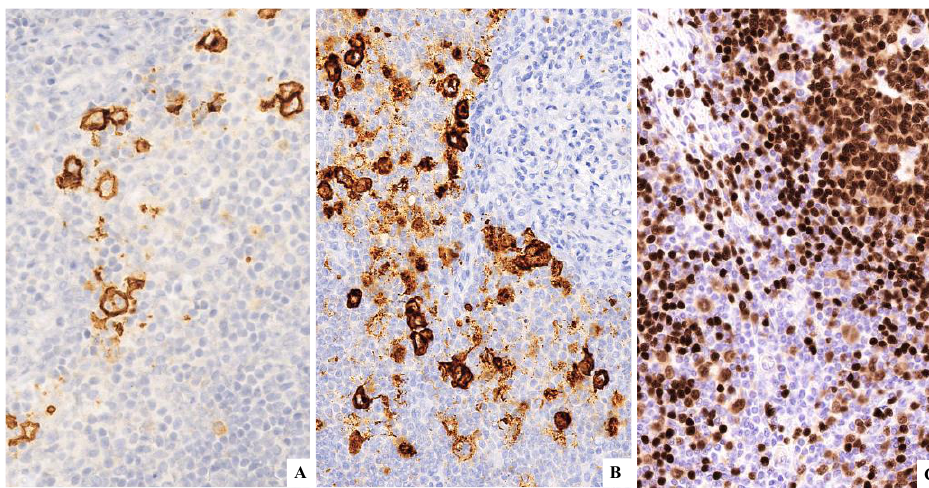
Figure 5. ( A ) CD30+. ( B ) CD15+. ( C ) PAX5+ weak.